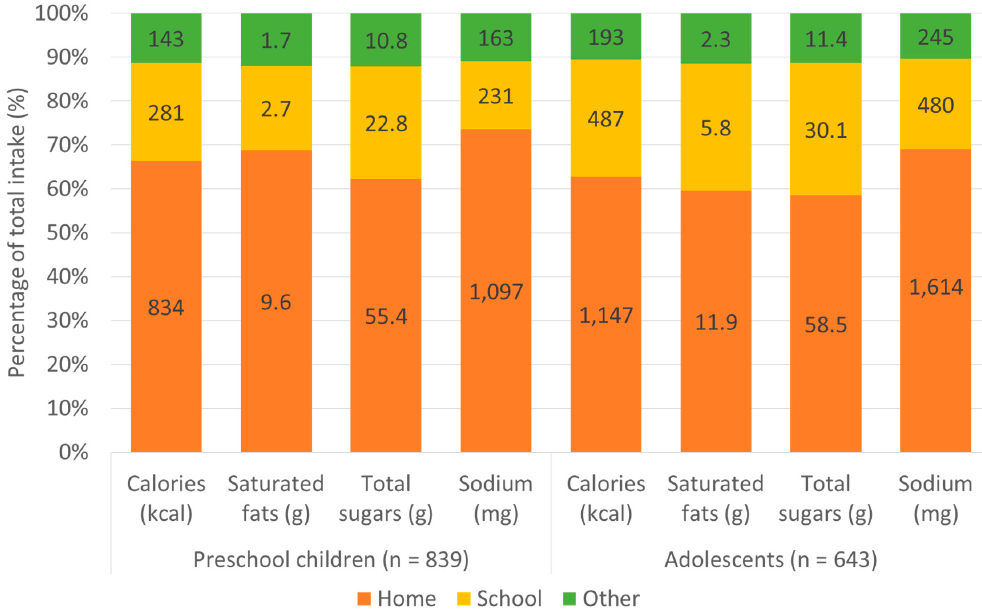
Figure 2. Percentage and absolute per capita intake of calories and key nutrients of concern by eating location among low- and middle-income Chilean preschool children and adolescents from Southeast Santiago, 2016. Note: Values inside the bars represent the absolute intake by eating location. We calculated percentages by dividing the total intake of each nutrient by the intake at each eating location.